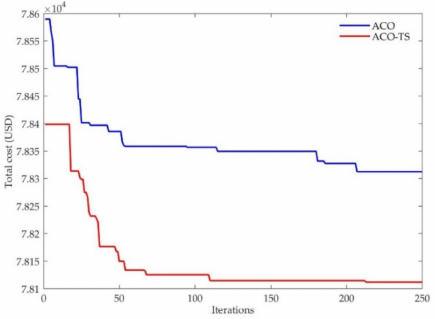
Figure 7. Iterative convergence comparison graph of ACO-TS and ACO.